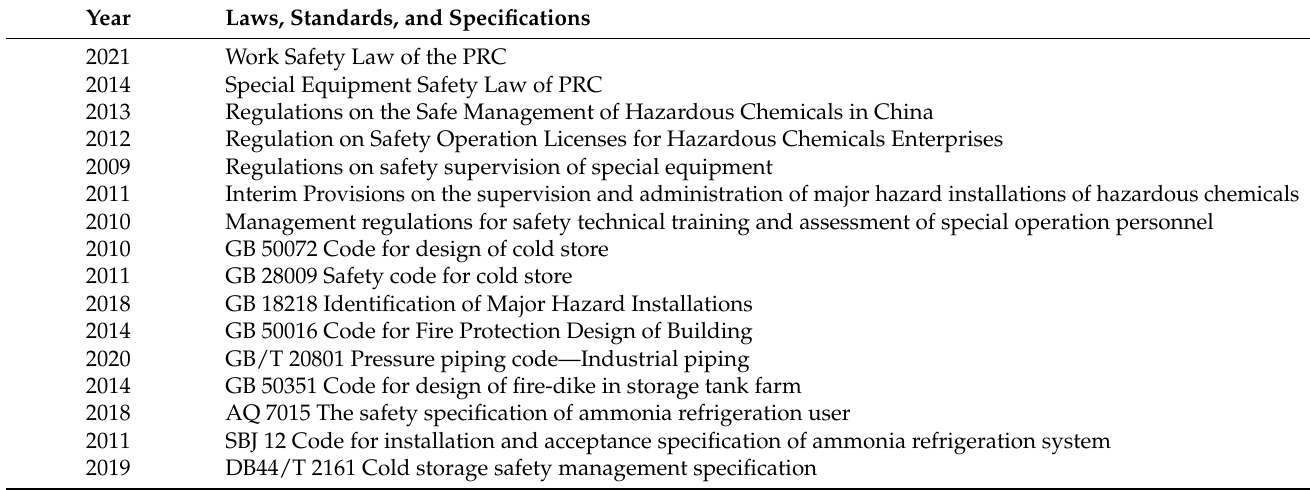
Table 5. Main standards and specifications in ammonia-related refrigeration field.